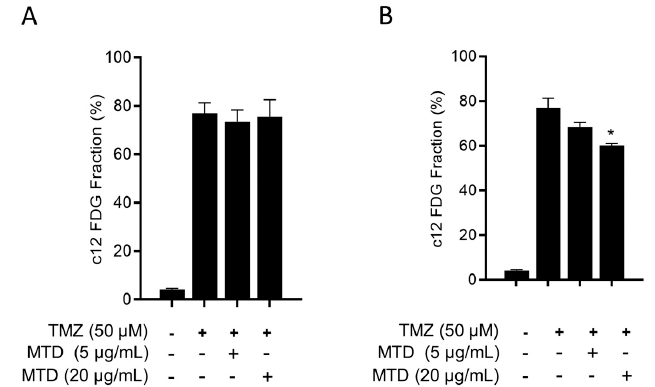
Figure 9. Effect of MTD on TMZ-induced senescence. ( A ) Induction of senescence by TMZ in LN229 cells and effect of MTD co-treatment on senescence induction. ( B ) Effect of MTD on the TMZ-induced senescent cell level. Data are the mean of three independent experiments +/-SEM. * p ≤ 0.05.